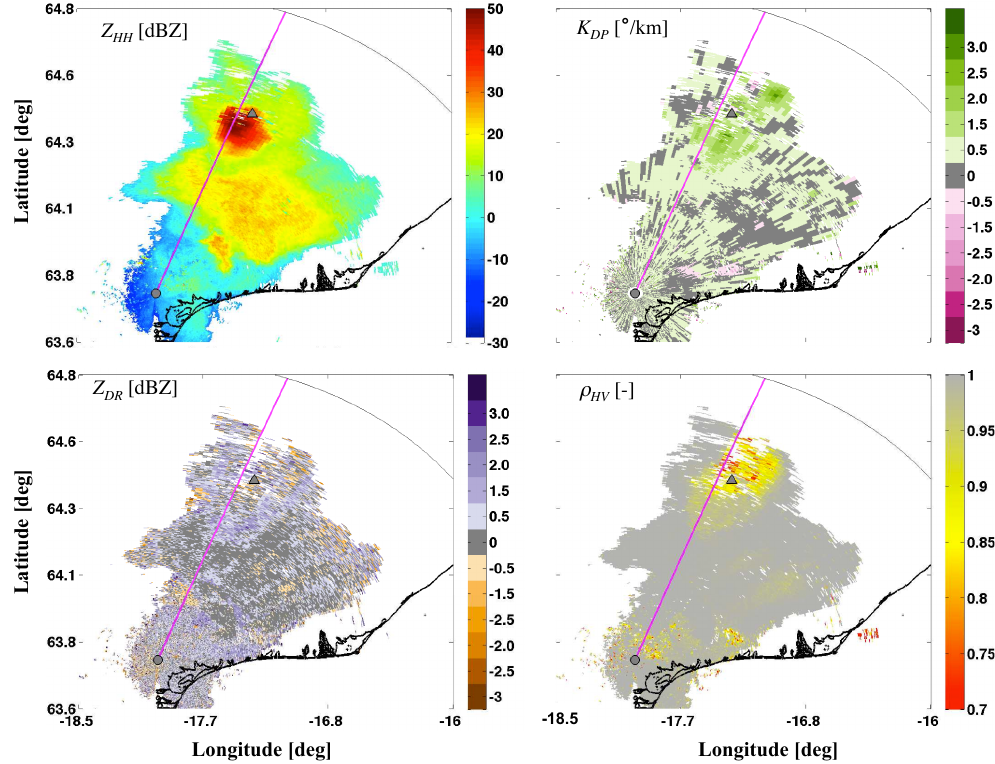
Fig. 4. Vertical maximum intensity of radar variables Z HH , K DP , Z DR and ρ HV as specified in the top right corner of each panel for the Grímsvötn case study on 22 May 2011, 07:12UTC. Note the values of all the radar variables here shown are extracted from the positions (range, azimuth, height) where the maximum of the radar reflectivity, Z HH , is registered along each vertical profile. The radar and the volcano vent positions are indicated, in each panel, with the symbols “O” and “ 1 ”, respectively. The coastline is in black. The magenta-coloured line shows the azimuth at 21deg clockwise from the north where the vertical cuts in Fig. 5 are